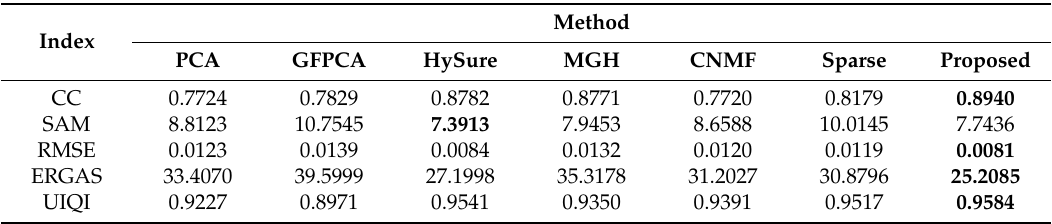
Figure 10. Visual comparison of difference image (light blue means small differences) between each fused HS image and the reference HS image (Washington DC dataset). ( a ) PCA; ( b ) GFPCA; ( c ) HySure; ( d ) MGH; ( e ) CNMF; ( f ) Sparse Representation; ( g ) Proposed. Table 3. Quality metrics of different methods for Washington DC dataset.